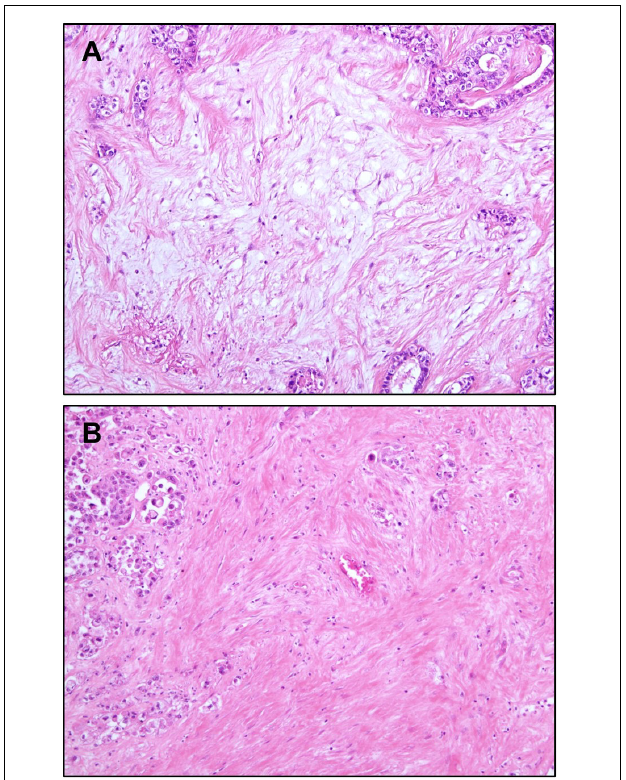
FIGURE 5 | Stromal features of intrahepatic cholangiocarcinoma. (A) Immature stroma showing pale basophilic myxoid appearance. Activated fibroblasts are the main components of the stroma. Collagen fibers are incomplete and thin. (B) Mature stroma showing thick collagen bundles, making its eosinophilic color. Original magnification: 100 ×